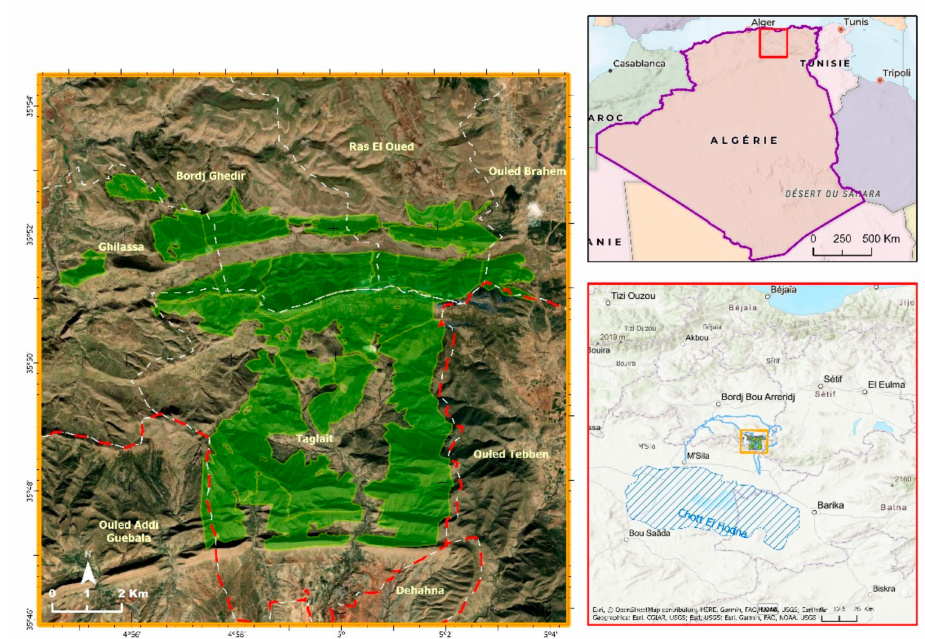
Figure 2. Location map of the Ouled Hann è che